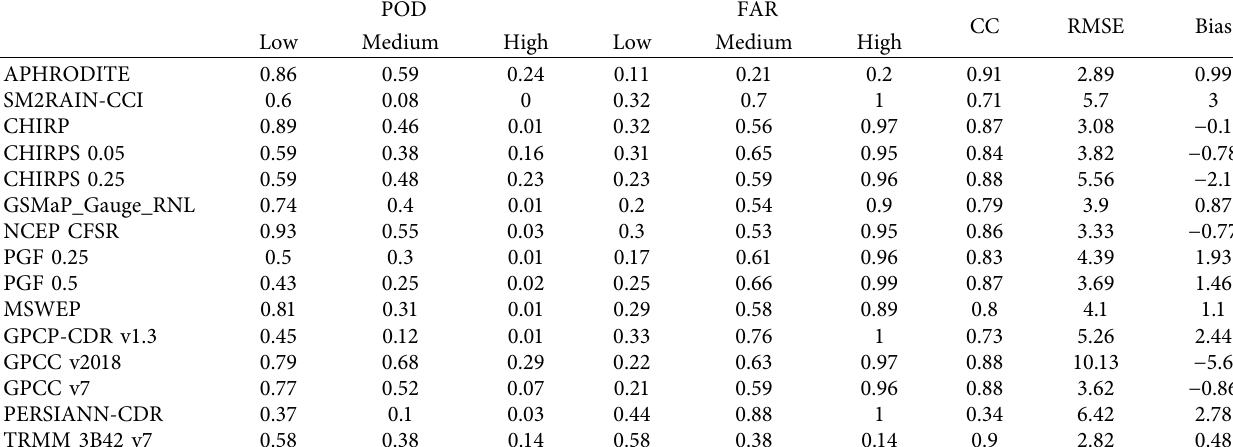
Table 3: Continuous and categorical statistics of precipitation datasets compared to IMD.